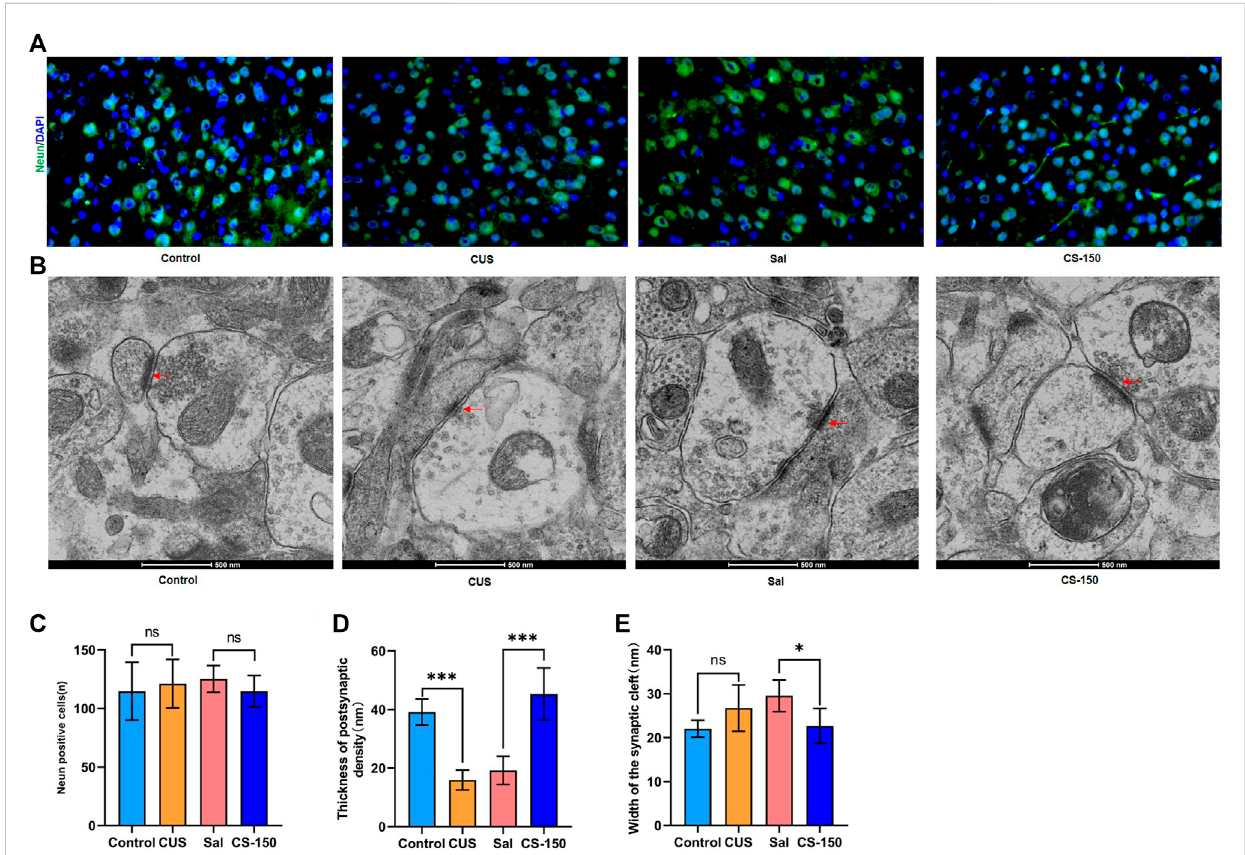
FIGURE 6 CS altered the synaptic ultrastructure. (A) Images of Neun-positive cells in the PFC (under ×400 magni fi cation) obtained by immuno fl uorescence. (B) Synaptic ultrastructure of the mPFC under ×60,000 magni fi cation. (C) The number of Neun-positive cells. (D) Thickness of PSD of the PFC. (E) Synaptic cleft width of the PFC. Data are expressed as the mean ± standard error. * p < 0.05, ** p <